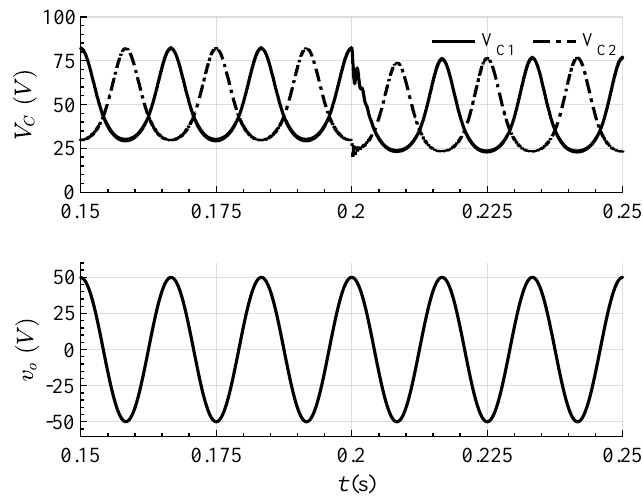
Figure 20. Voltages across the individual converters and the differential output due to a step change in the input supply. The input drops from 22V to 18V.